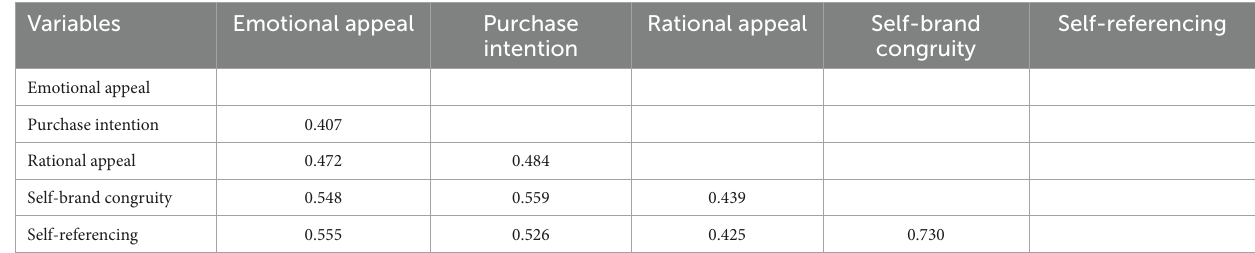
TABLE 5 Discriminant validity of measurement model